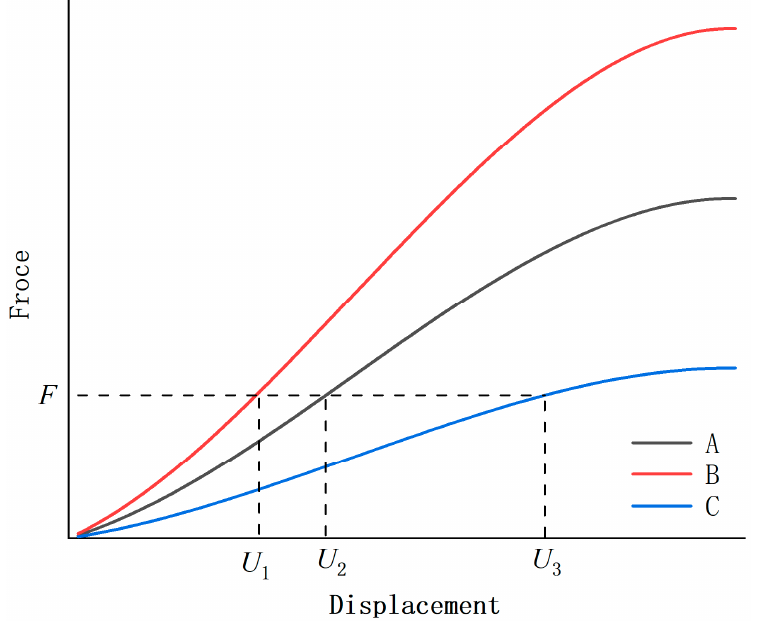
Figure 2. Radial-force comparison of three types of tires.